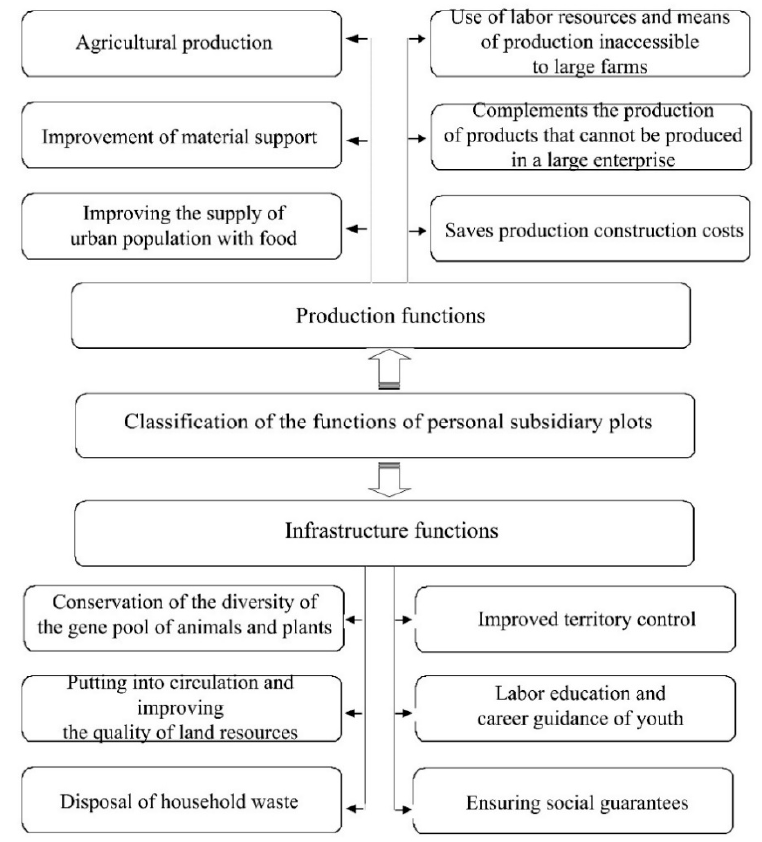
Figure 16. Classification of household functions.